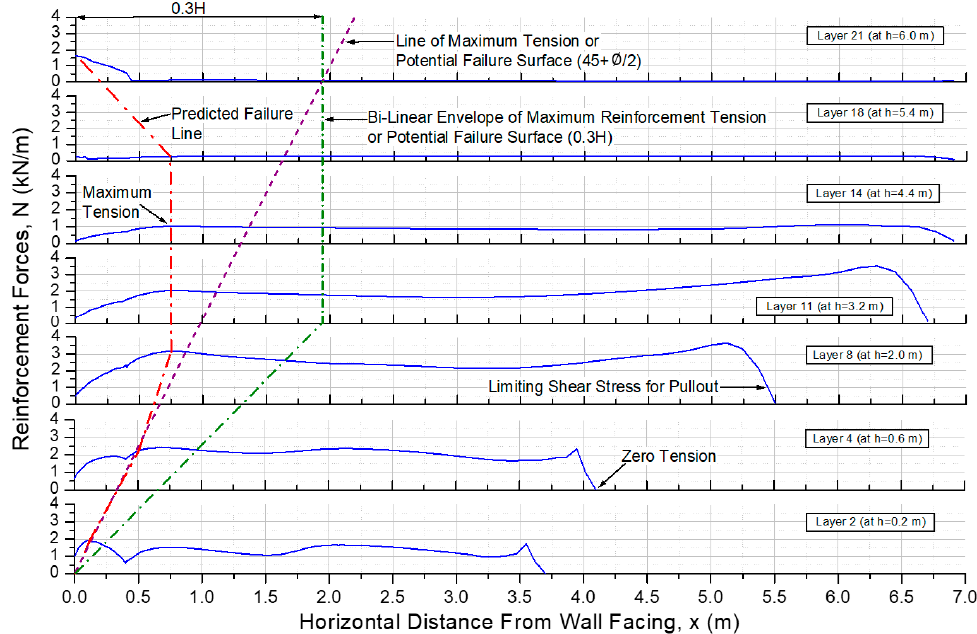
Appl. Sci. 2021 , 11 , x FOR PEER REVIEW Figure 13. Distribution of reinforcement forces at seven elevations within the GRS abutment for Case 1.